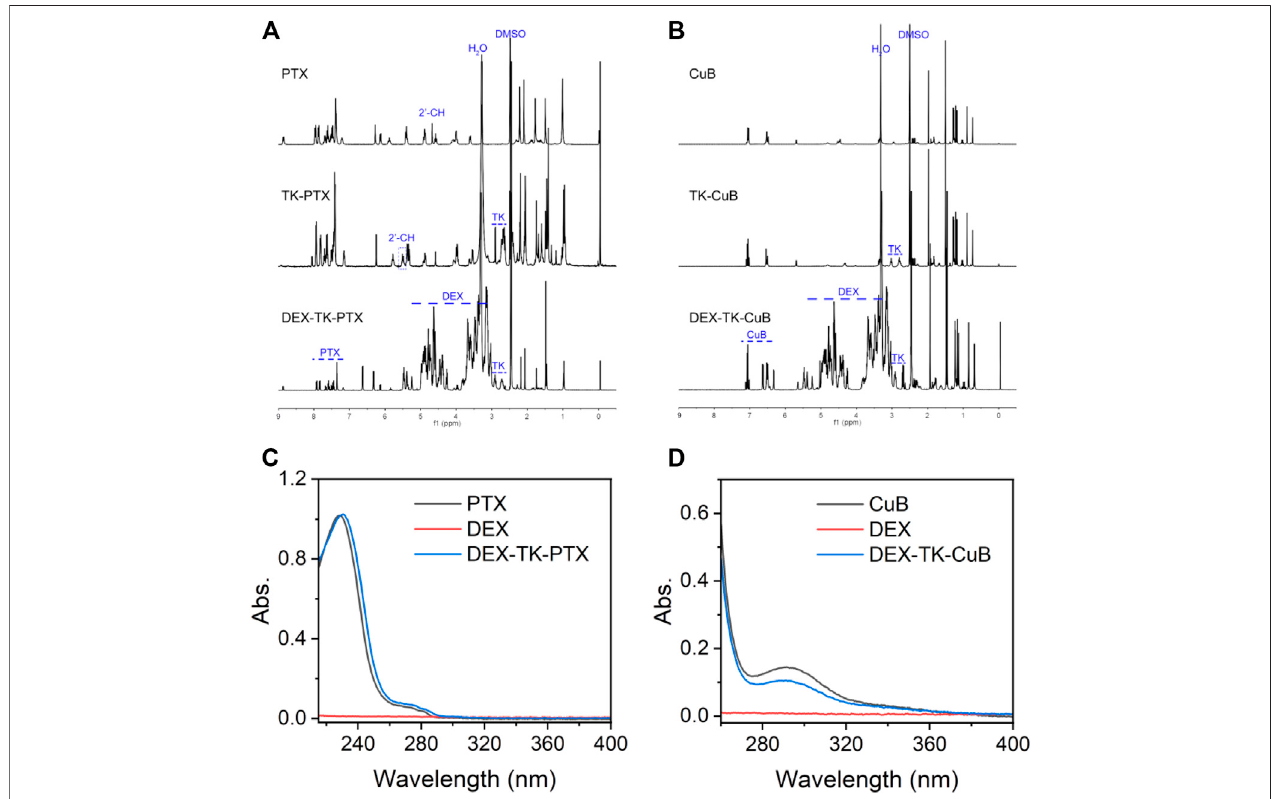
FIGURE1| Characterizationofprodrugs. (A) 1 HNMRspectraofPTX,TK-PTX,andDEX-TK-PTXinDMSO- d6 . (B) 1 HNMRspectraofCuB,TK-CuB,andDEX-TK- CuB in DMSO- d6 . (C) UV spectra of PTX, TK-PTX, and DEX-TK-PTX. (D) UV spectra of CuB, TK-CuB, and DEX-TK-CuB.